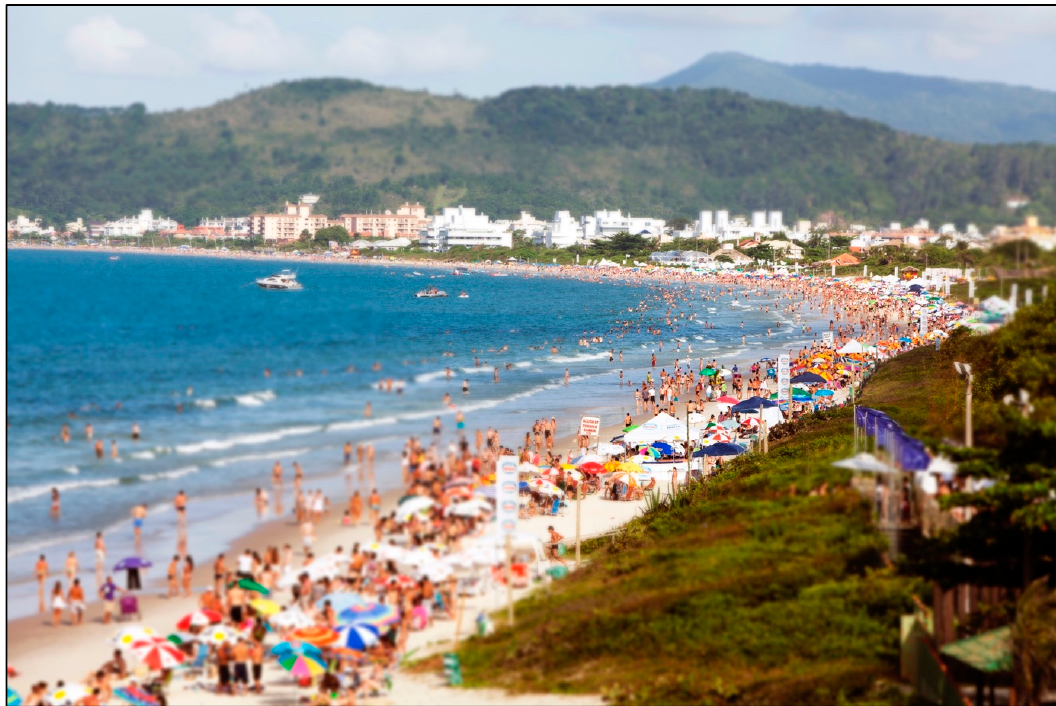
Figure 3. A view of the Jurere International Beach, reproduced with permission from Eduardo Zappia (photo taken in February 2018).